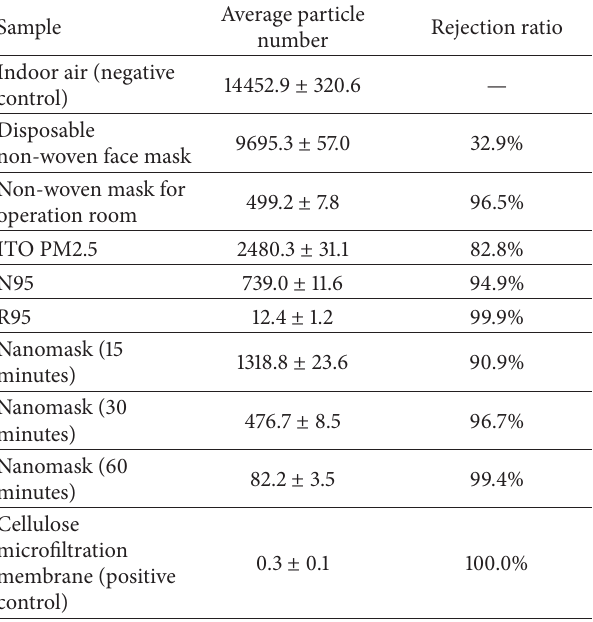
Table 3: PM2.5 rejection by selected